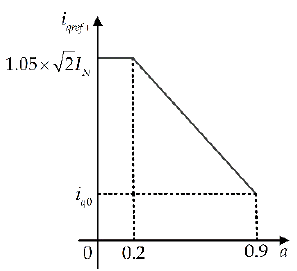
Figure 2. Command reference of positive-sequence reactive current when a < 0.9.